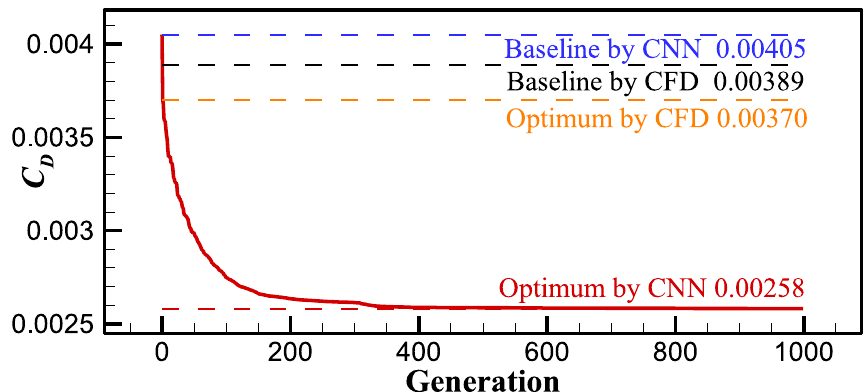
Fig. 31 Convergence history of aerodynamic shape optimization for the wing (optimization case 3)